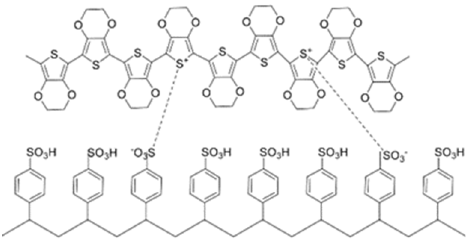
Figure 5. Molecular structure of PEDOT:PSS [63].